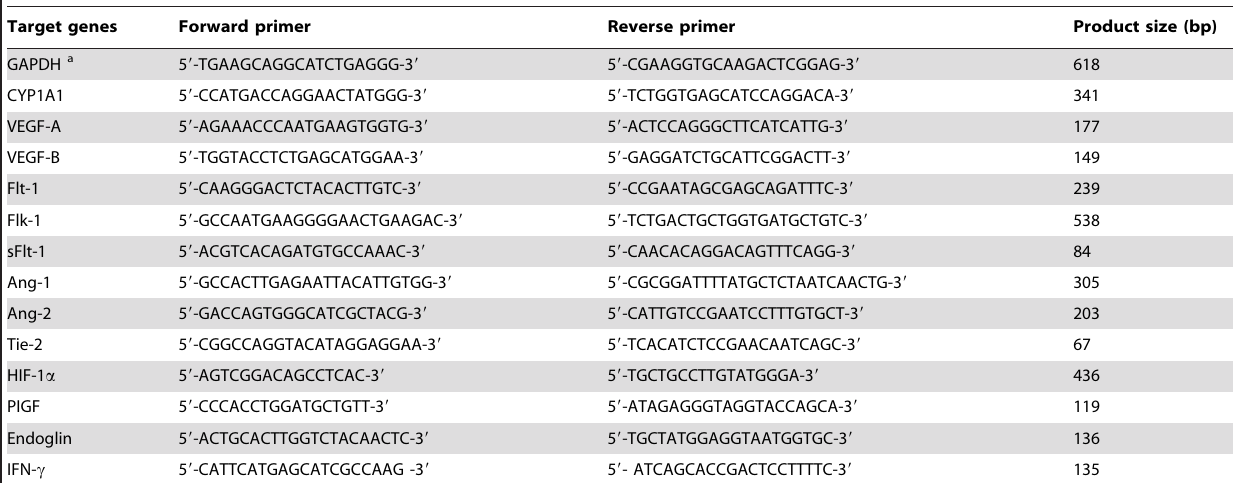
Table 1. Real-time PCR